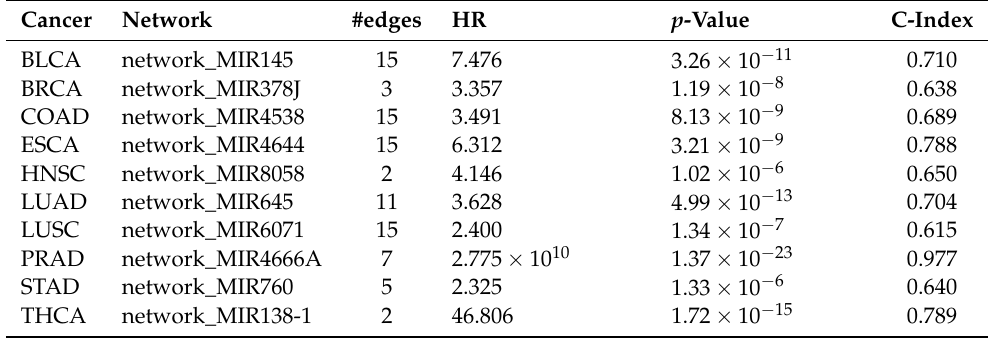
Table 6. The top subnetworks with the lowest p -value of the log-rank test for each type of cancer.